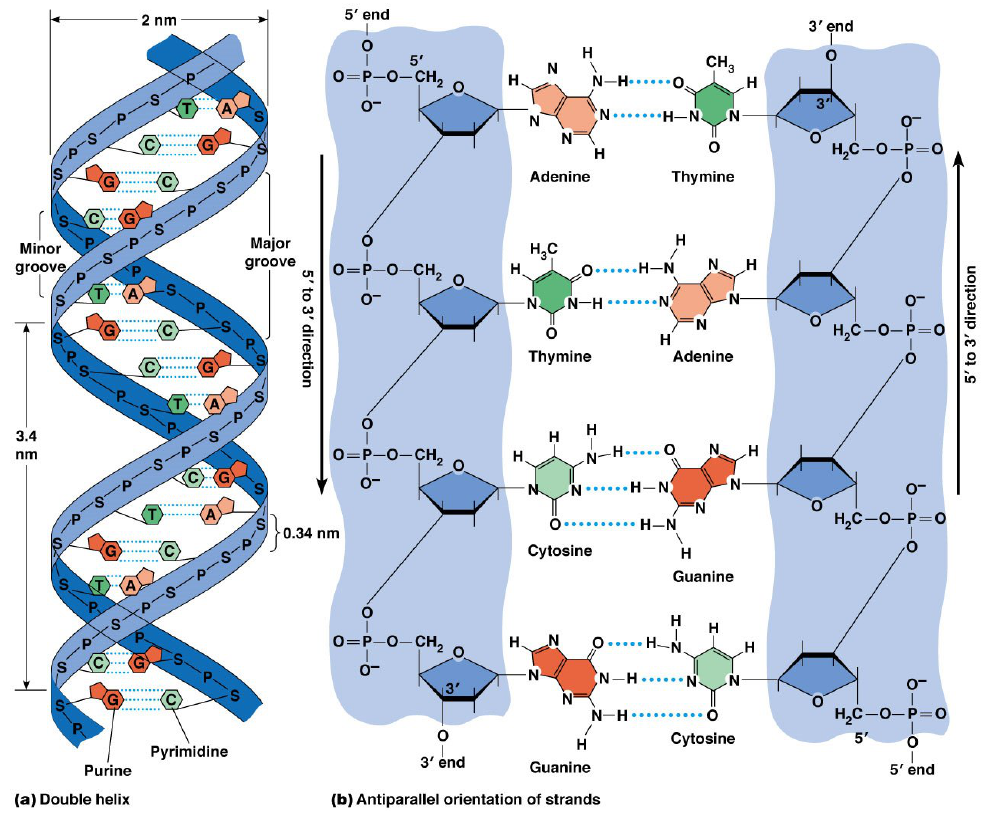
Figure 2. Structure of a DNA molecule [13].